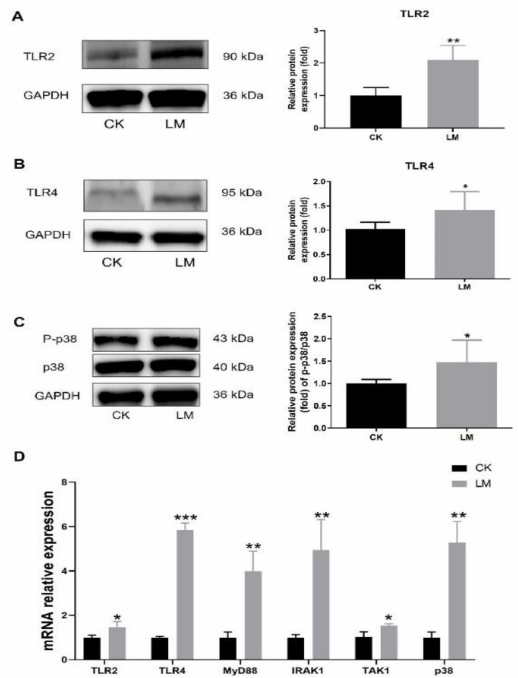
Figure 6. The increase in components in TLR2/4 signaling pathways upon L. monocytogenes infection in organoids. ( A – C ) Western blot of TLR2, TLR4 and P-p38/p38 in organoids. ( D ) mRNA levels of TLR2 , TLR4 , MyD88 , IRAK1 , TAK1 and p38 from organoids samples. * p < 0.05, ** p < 0.01, *** p <